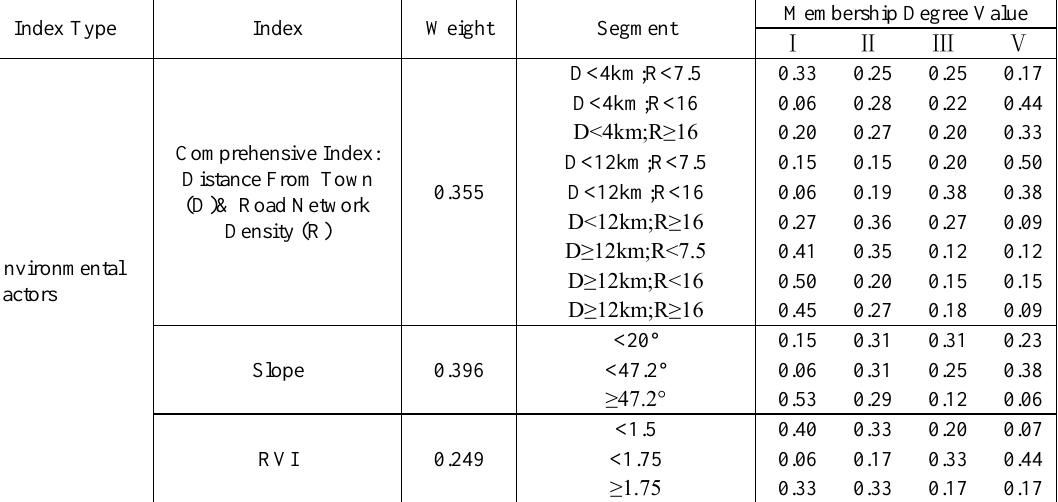
Table 3. Membership of influencing factors according to the frequency ratio